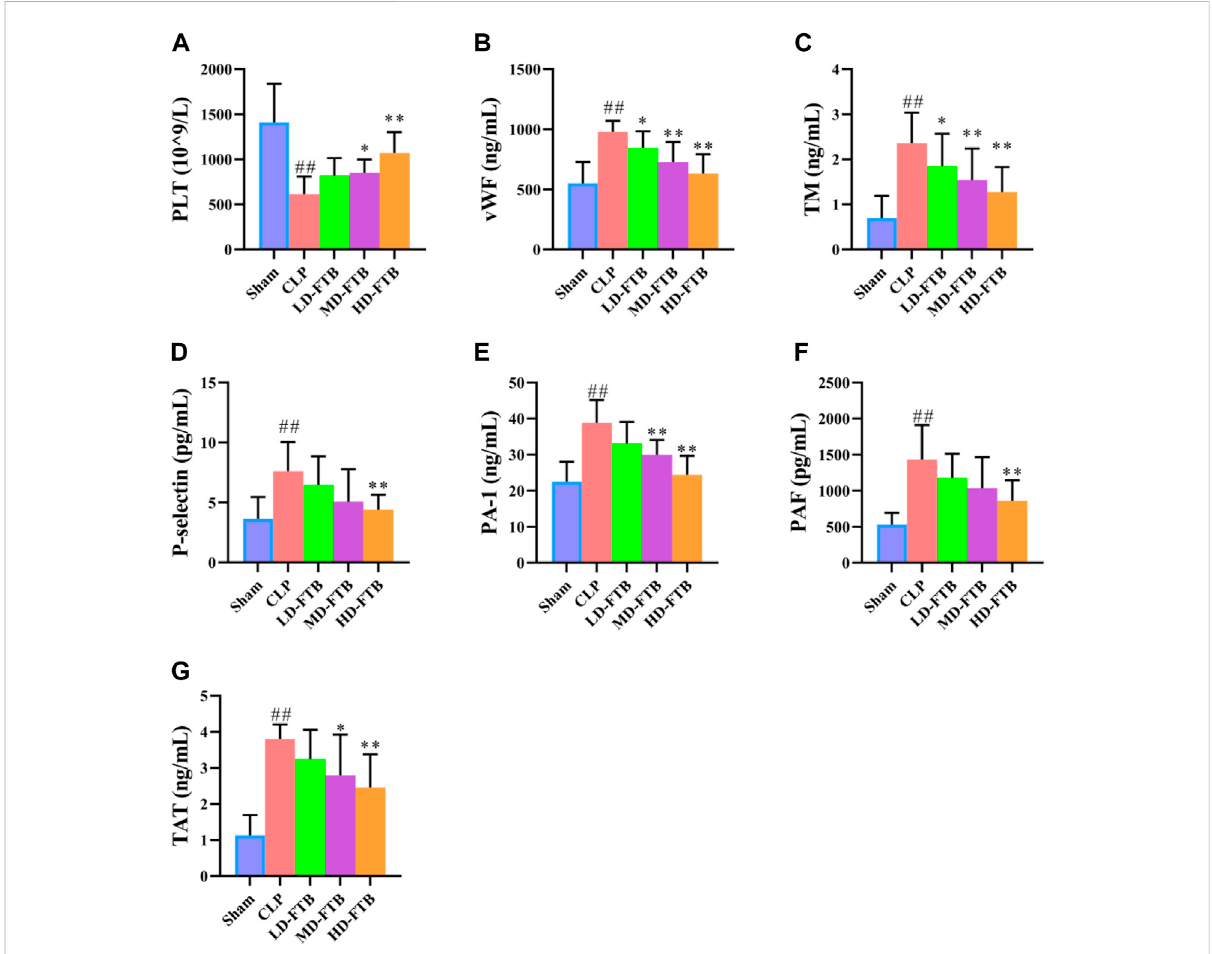
FIGURE 4 Effects of FTB on coagulation function in rats with sepsis. We investigated the platelet (PLT) count using blood routine examination (A) , the serum levels of von Willebrand factor (vWF) (B) , thrombomodulin (TM) (C) , P-selectin (D) , plasminogen activator inhibitor 1 (PAI-1) (E) , platelet-activating factor (PAF) (F) , and thrombin – antithrombin complex (TAT) (G) using ELISA, and the expression of thrombin in lung, liver and kidney using immunohistochemistry (black arrows indicate the positive expression areas) (magni fi cation: ×100) (H) ; the thrombin- positive expression area detected using immunohistochemistry was quanti fi ed based on the average optical density (AOD) (I) . FTB treatment increased the PLT count, decreased the levels of coagulation factors (vWF, TM, P-selectin, PAI-1, PAF, TAT) and lowered the expression of thrombin in lung, liver and kidney in rats with sepsis. Sham (n = 15), CLP ( n = 8), LD-FTB ( n = 9), MD-FTB ( n = 10), HD-FTB ( n = 12).